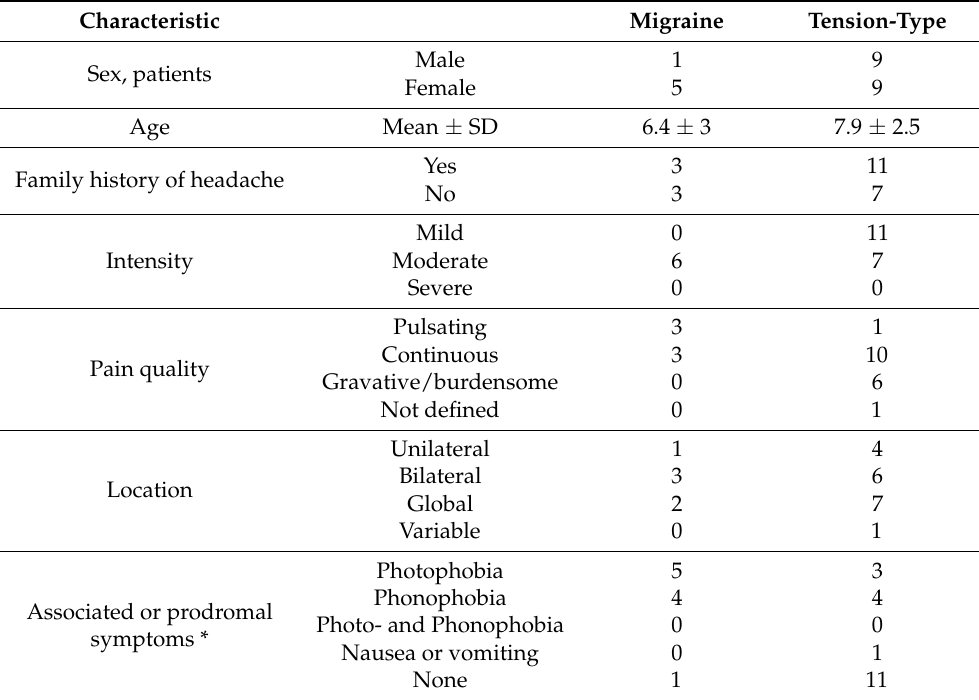
Table 4. Patterns of headache and characteristics among 24 patients who developed post-traumatic headache (PTH) and completed 6 month follow-up.